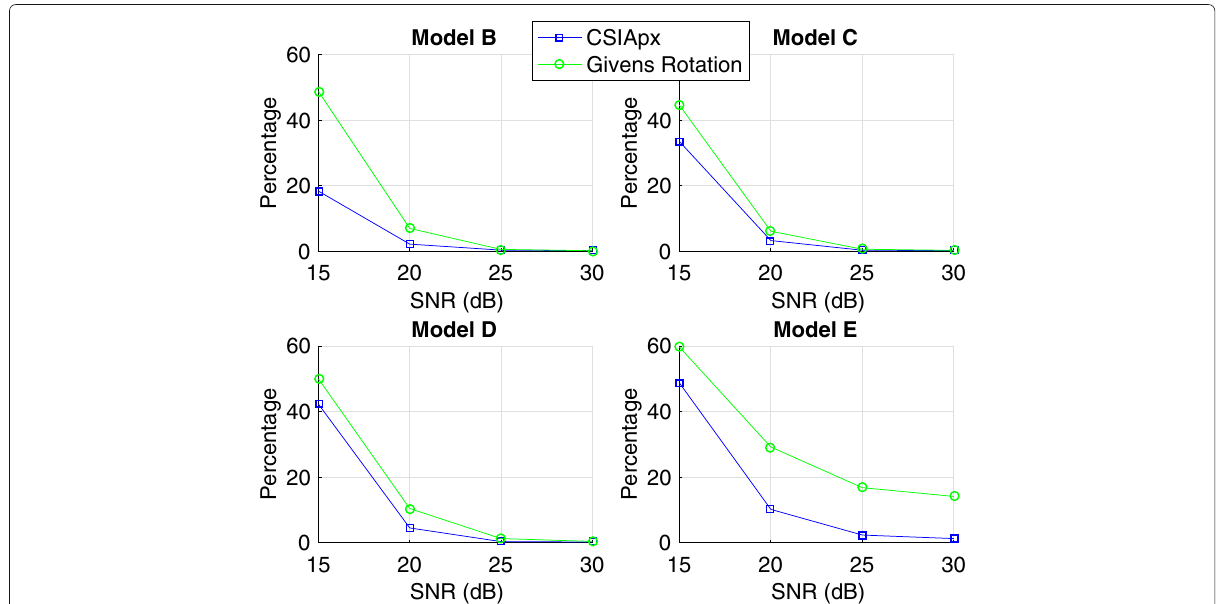
Fig. 16 MU-MIMO rate difference comparison with Givens rotation. The percentage of cases where the normalized rate differences are above 3% or lower than − 3% is shown when running CSIApx versus Givens rotation on the synthesized CSI data